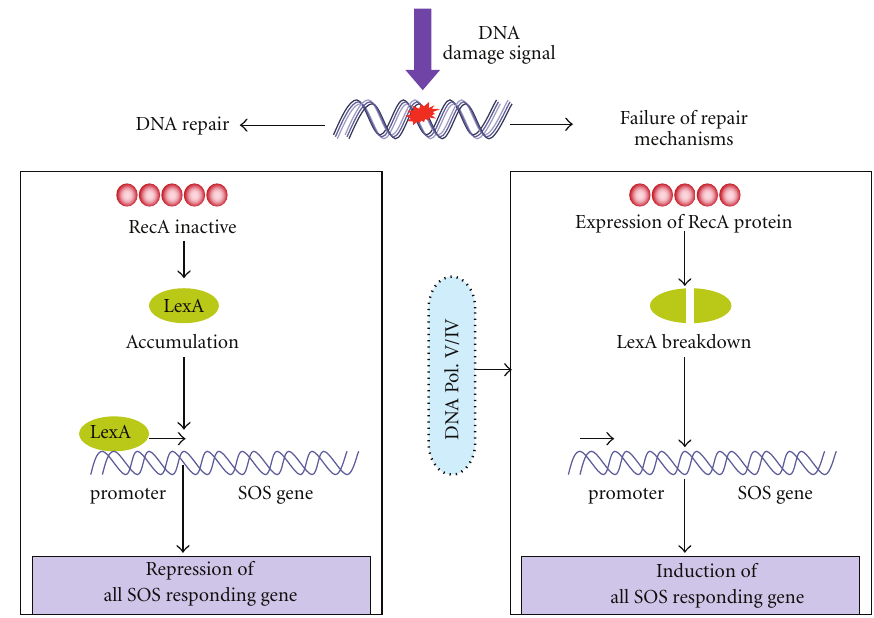
Figure 14: SOS response: As a result of massive DNA damage and failure of all possible repair mechanisms, RecA proteins is expressed, which activate the auto breakdown of LexA proteins, allowing the induction of all SOS responding genes. The pathway of SOS response is reversed when damages are repaired through the damage specific mechanisms. Here the inactivation of RecA protein allows the accumulation of LexA, which bind to SOS promoters and repress all SOS responding genes. SOS response is highly mutagenic due to involvement of DNA polymerase